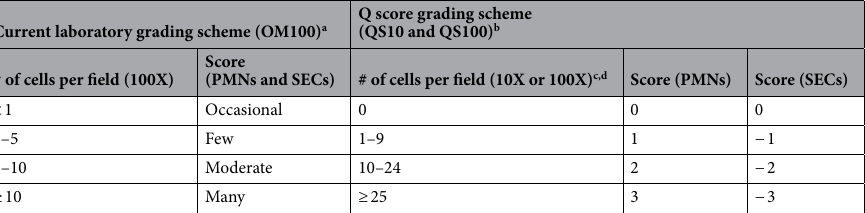
Table 1. Criteria used to evaluate Gram smears of wound swabs submitted for culture. a OM100 represents the Gram smear grading method used by the laboratory at the time of the study which provides a semi- quantitative assessment of the presence of squamous epithelial cells (SECs) and polymorphonuclear cells (PMNs) under high power (100X objective). b The Q score was determined by assessing the number of PMNs and SECs per field under (ii) low power (10X objective) (QS10) and (iii) high power (100X objective) (QS100). c The same number of cells per field were used for scoring under both QS10 and QS100. d The number of cells per field (100X) from the OM100 scheme was used for the QS100 Q score criteria applied to retrospectively collected wound